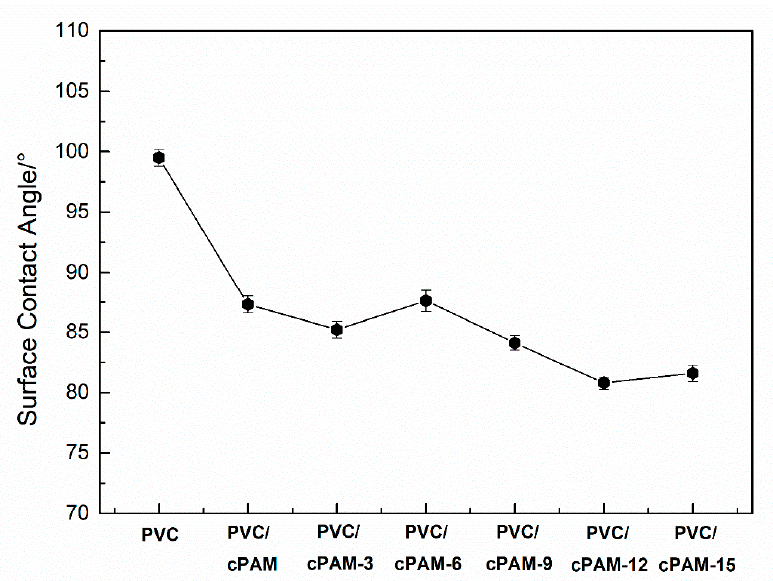
Figure 7. Surface contact angle of the PVC modified by cPAM.